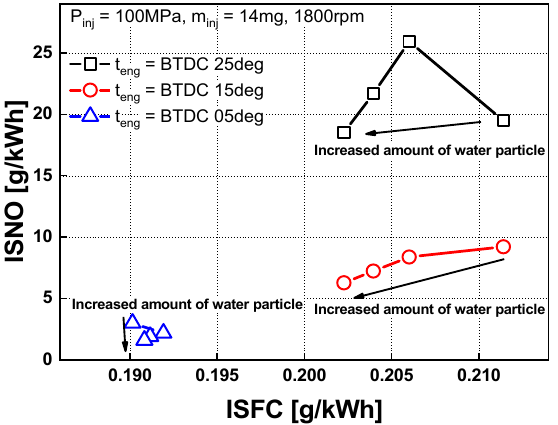
Figure 12. Effect of water vapor portion on the ISNO versus ISFC under different starts for energizing timing (P inj = 100 MPa, m inj = 14 mg, 1800 rpm).